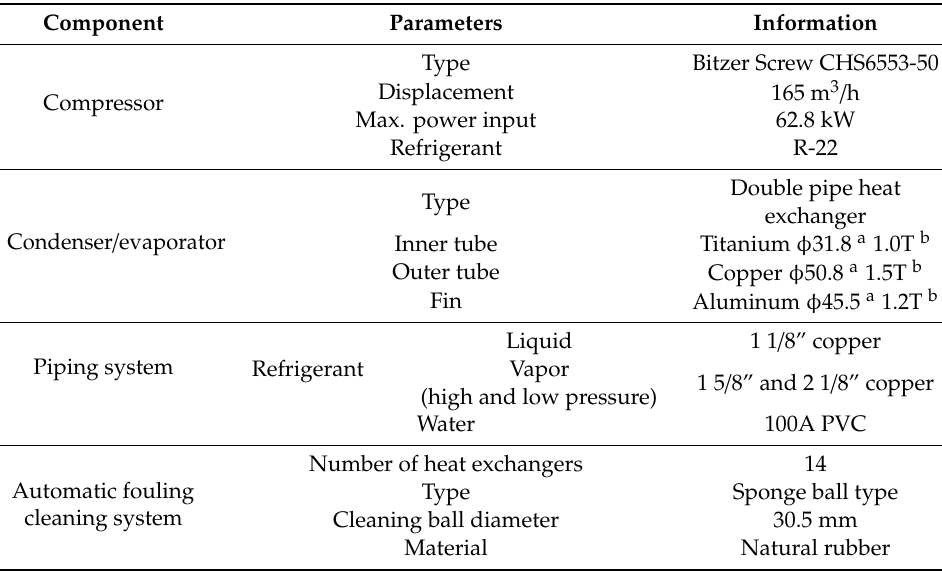
Figure 9. Schematic diagram of the 50 RT-scale field test for a fish farm. Table 3. Specifications of a 50 RT-scale field test unit.